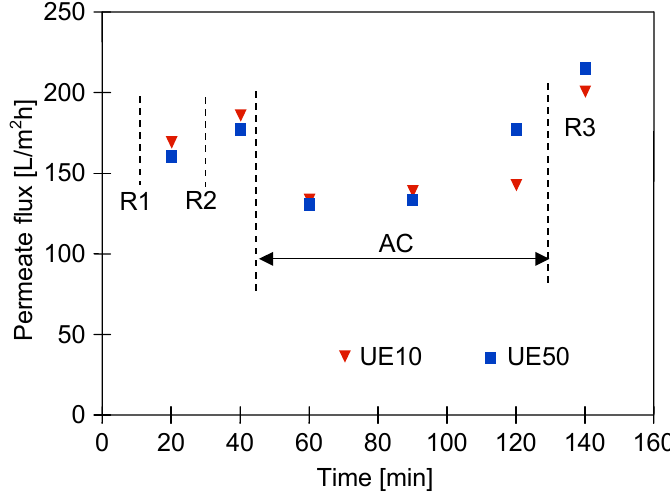
Figure 7. Changes in the permeate flux during cleaning of membranes contaminated with compo- nents of the blue+wax solution. R1, R2—membranes rinsed with NF permeate and soaked in water of the blue + wax solution. R1, R2—membranes rinsed with NF permeate and soaked in water for 12 h, AC-filtration of the green solution, R3—flushing the installation with the NF permeate.